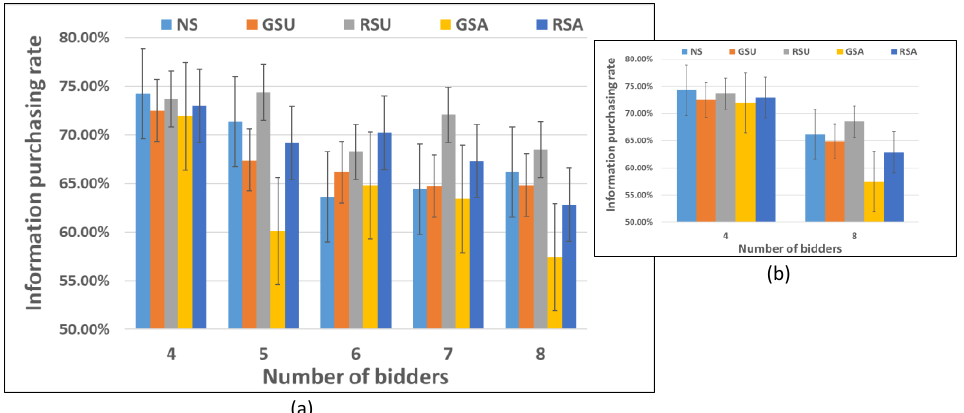
Figure 10. ( a ) Information purchasing rate as a function of the number of bidders participating in the auction. ( b ) A comparison between the information purchasing rate in an auction with 4 bidders and one with 8 bidders.